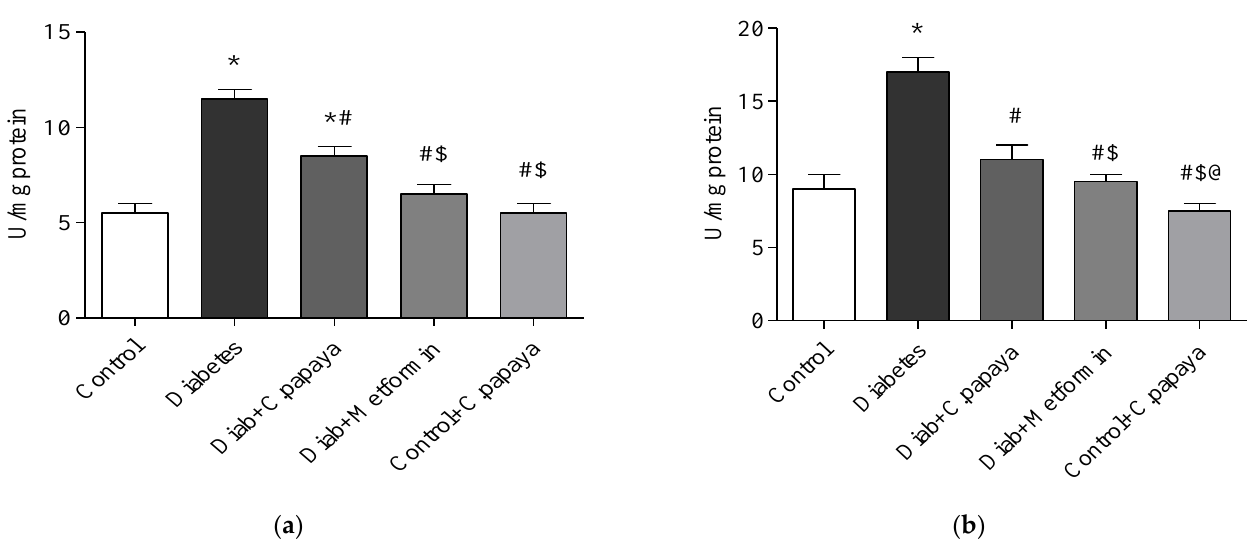
Figure 3. ( a , b ) Role of C. papaya on ( a ) G6P and ( b ) FBPase levels. p < 0.05 was considered statistically significant among the groups: *-control; #-diabetes; $- C. papaya -treated T2DM; @-T2DM rats + Metformin-treated T2DM.